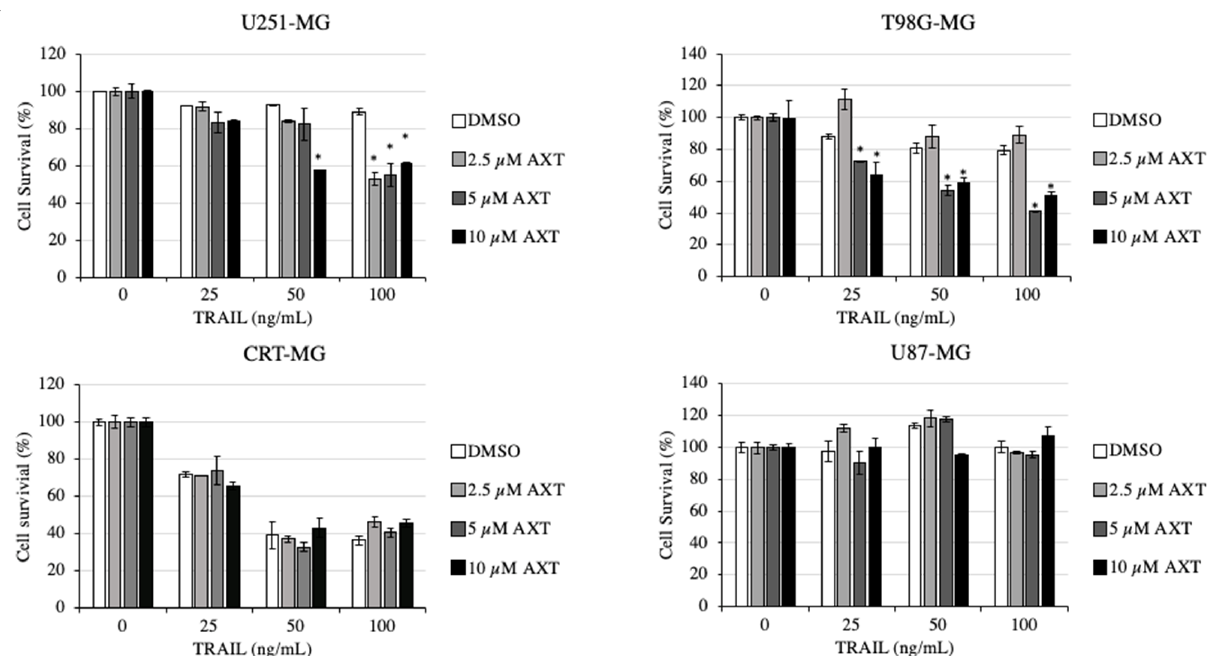
Figure 2. Astaxanthin specifically sensitizes U-251-MG and T98G-MG cell lines to TRAIL treatment while not effective to CRT-MG and U87-MG. GBM cell lines were pretreated with AXT from 2.5 to 10 µM or 0.1% DMSO as control for 3 h prior to treatment with TRAIL from 0 to 100 ng/mL for 16 h. Cell survivals are expressed in % as compared to 0.1% DMSO-treated control as 100%. Experi- 242 ments were performed in three biological replicates, and representative results are shown with av- 243 erage and SD. * p < 0.05, significantly different from the DMSO group (Dunnett’s test).